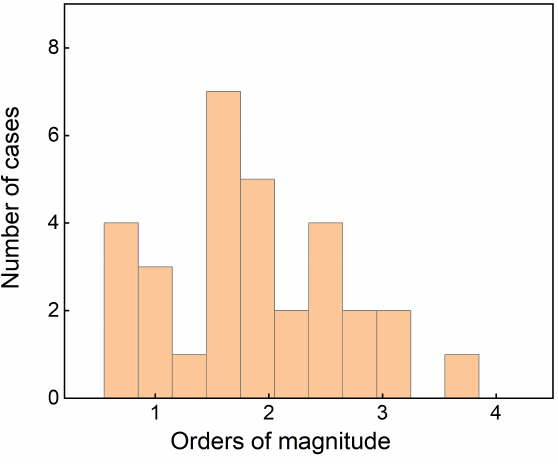
Figure 11. Histogram of magnitude span in fractal calculation of thin